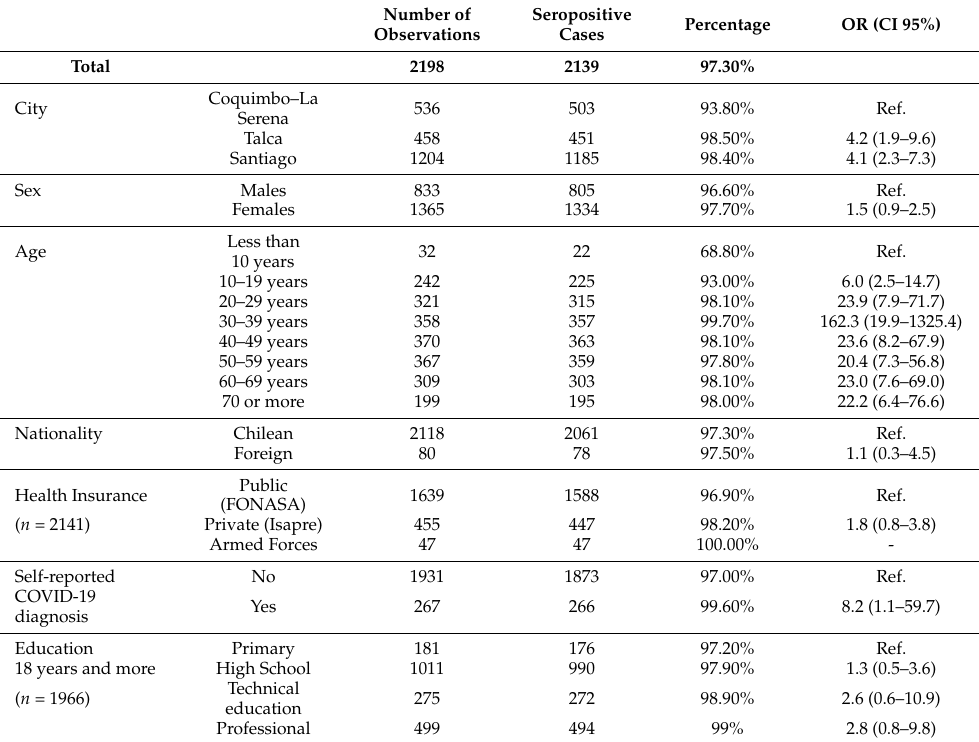
Table 1. Total sample SARS-CoV-2 seroprevalence by